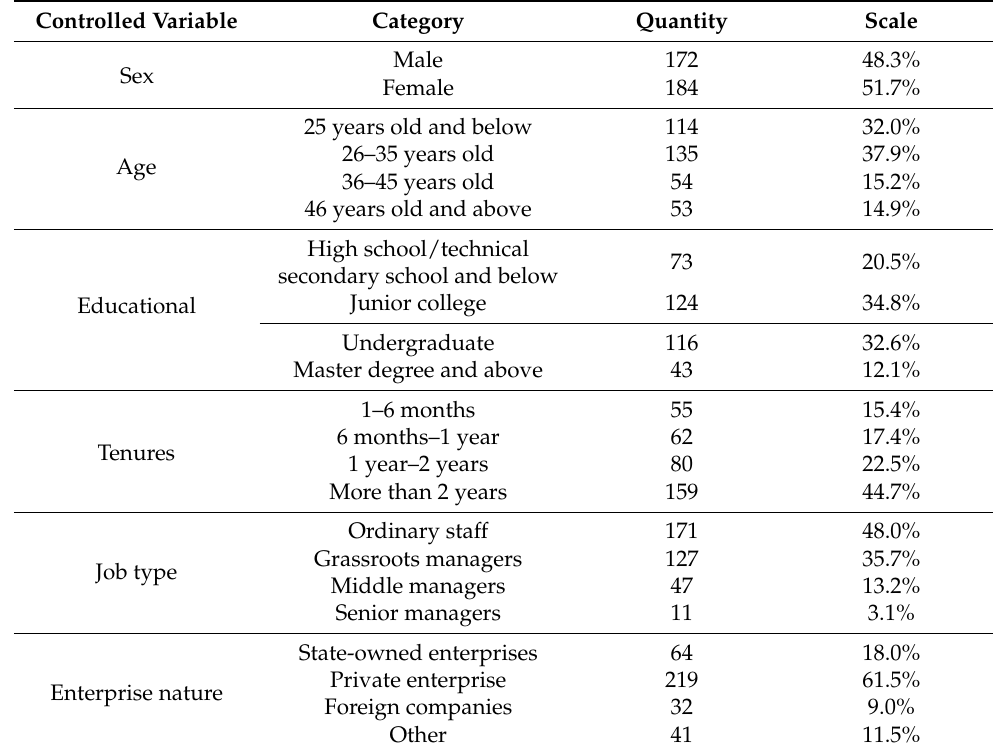
Table 1. Descriptive statistics of control variables of the survey sample ( n =